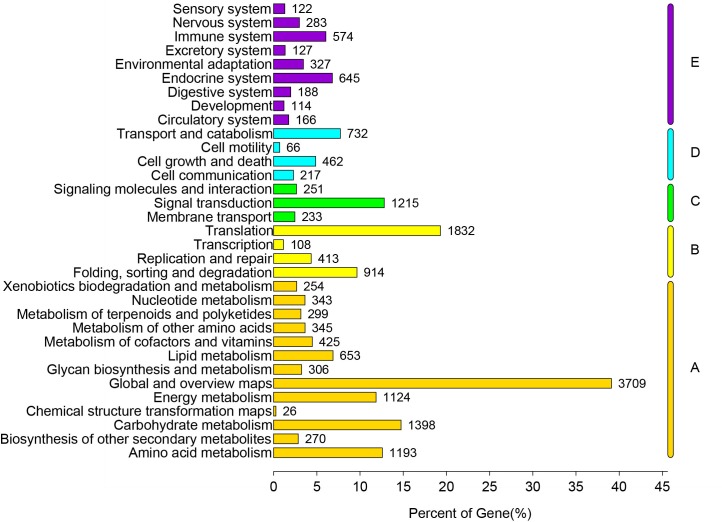
Pathway assignment based on the Kyoto Encyclopedia of Genes and Genomes (KEGG).(A) Classification based on metabolism categories, (B) Classification based on genetic information processing categories, (C) Classification based on environmental information processing categories, (D) Classification based on cellular processes categories, and (E) Classification based on organismal systems categories.